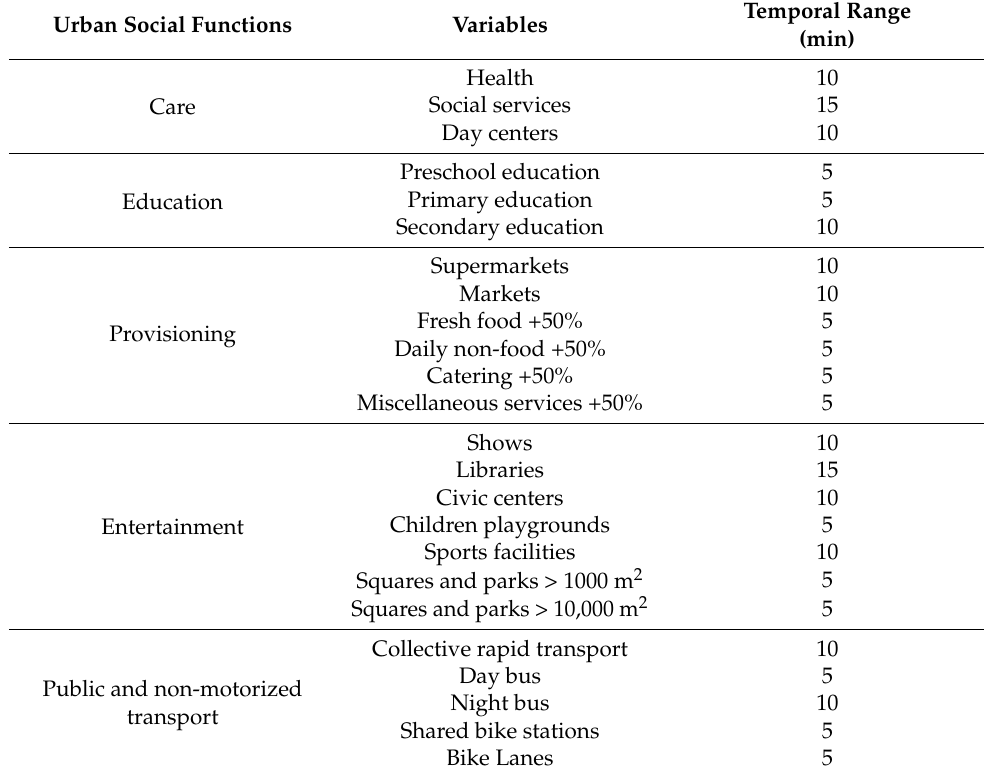
Table 1. Urban social functions and their specific